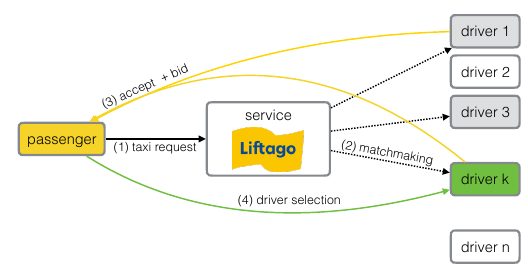
Figure 4. Liftagoserviceoverview. It takes foursteps to issue a ride order:passenger sends a request (1), Liftago designates a